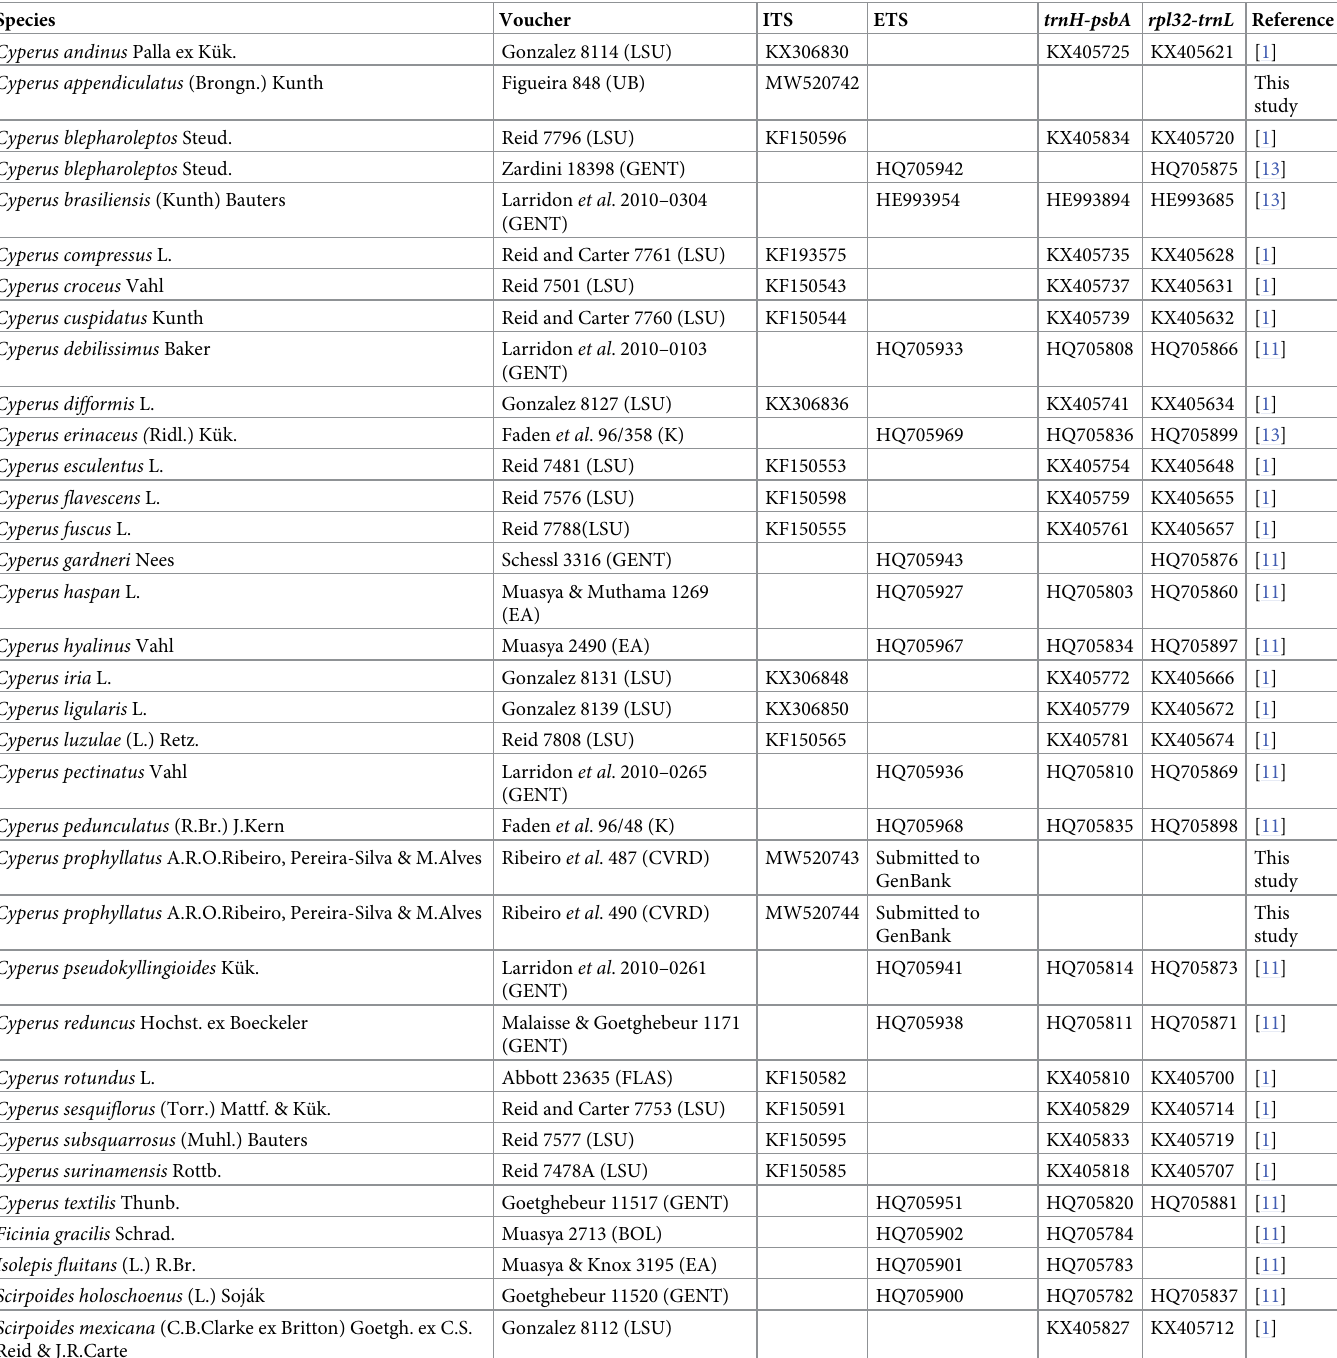
Table 1. List of the samples, voucher, and GenBank accessions numbers for the species used in the phylogenetic